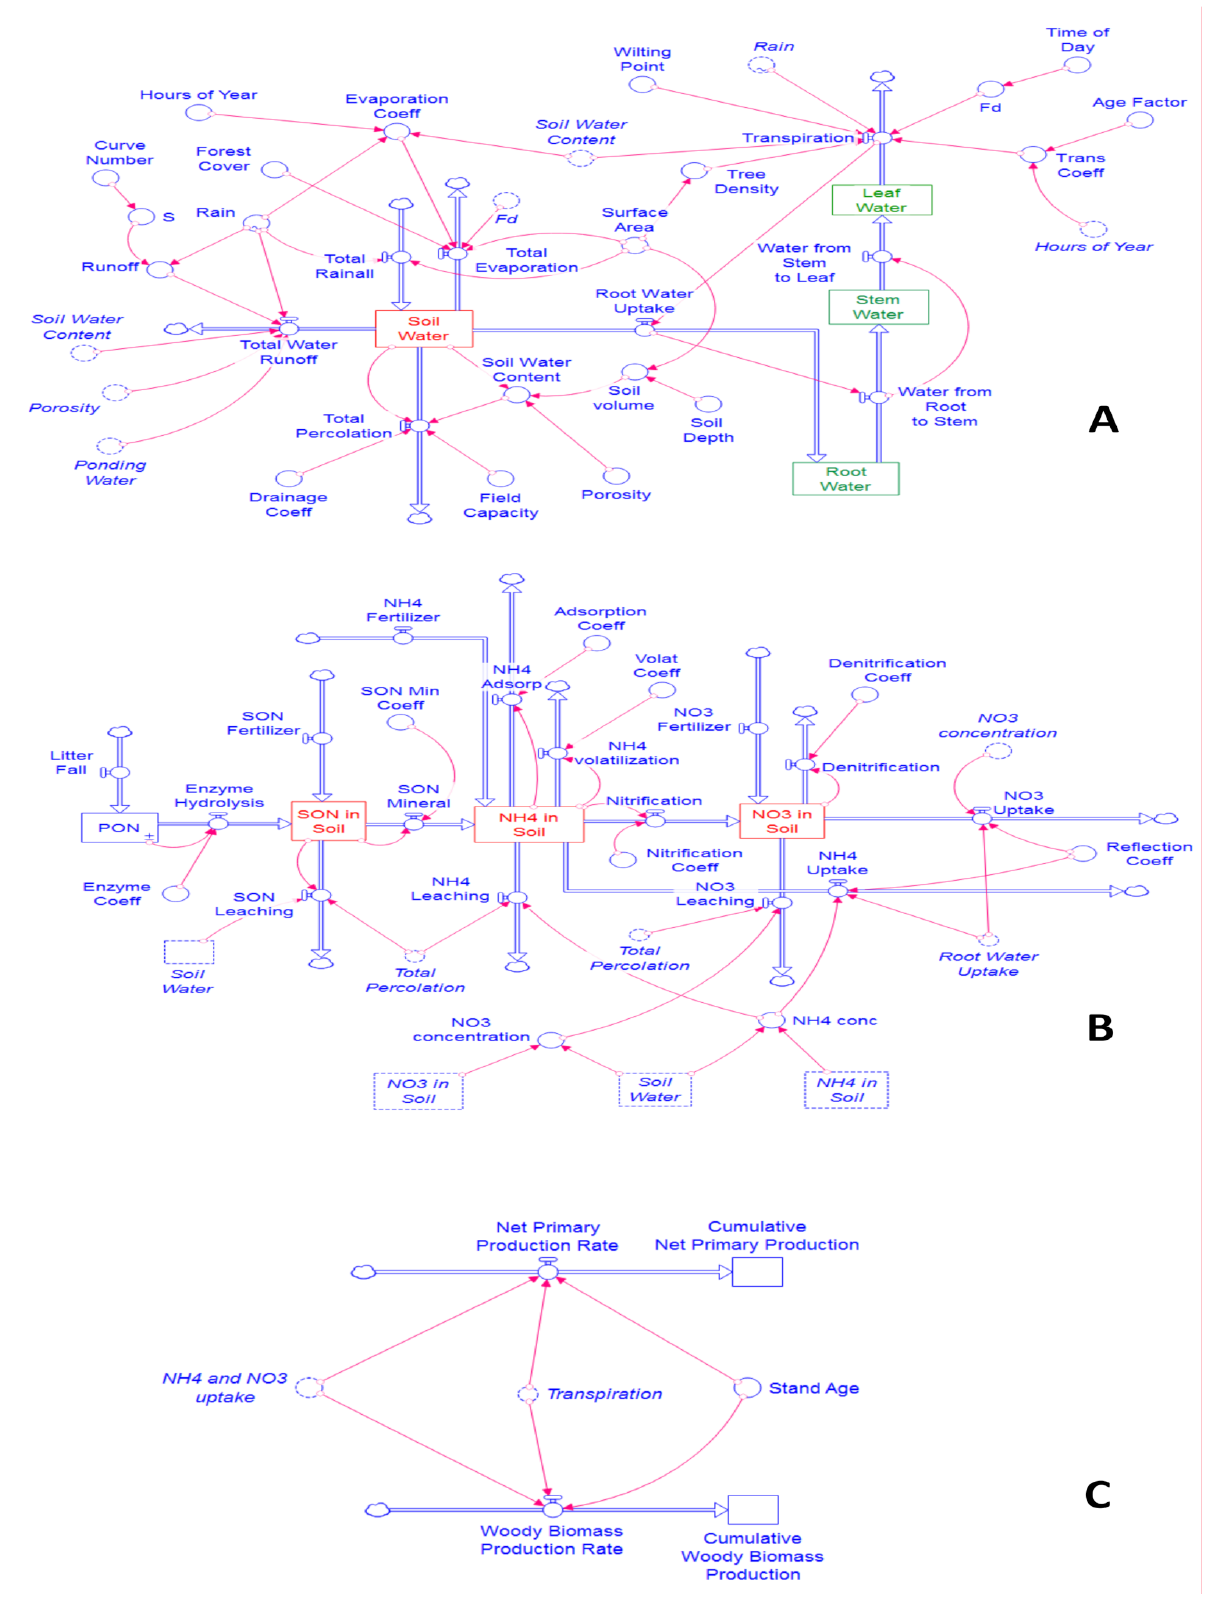
Figure 2. A general STELLA model map showing soil water dynamics ( A ), N dynamics ( B ), and biomass production ( C